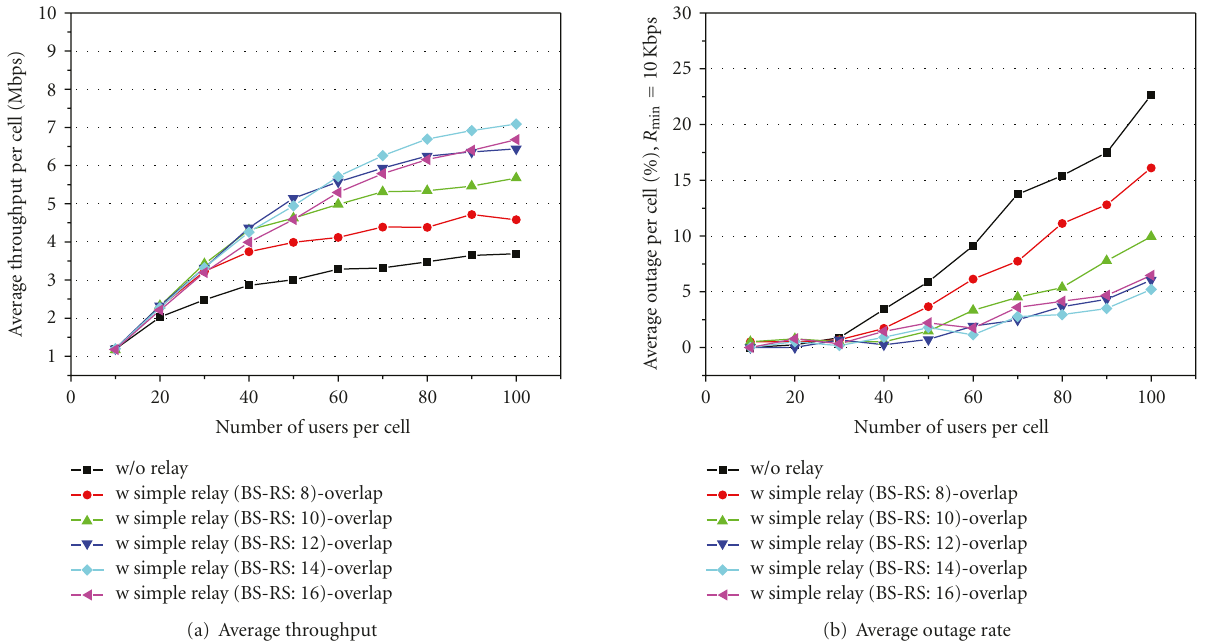
Figure 4: Average throughput and outage performance for a multihop relay with overlapped allocation.